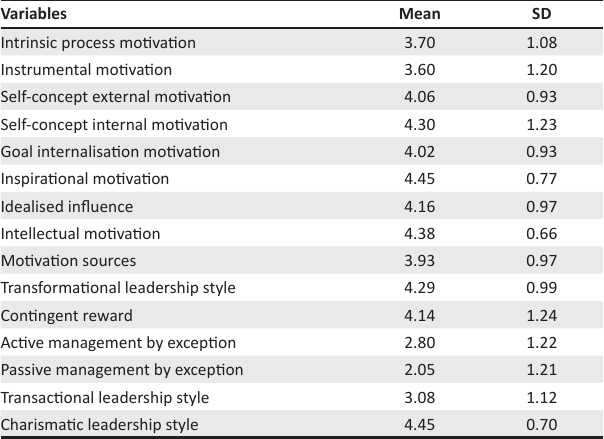
TABLE 1: Variables’